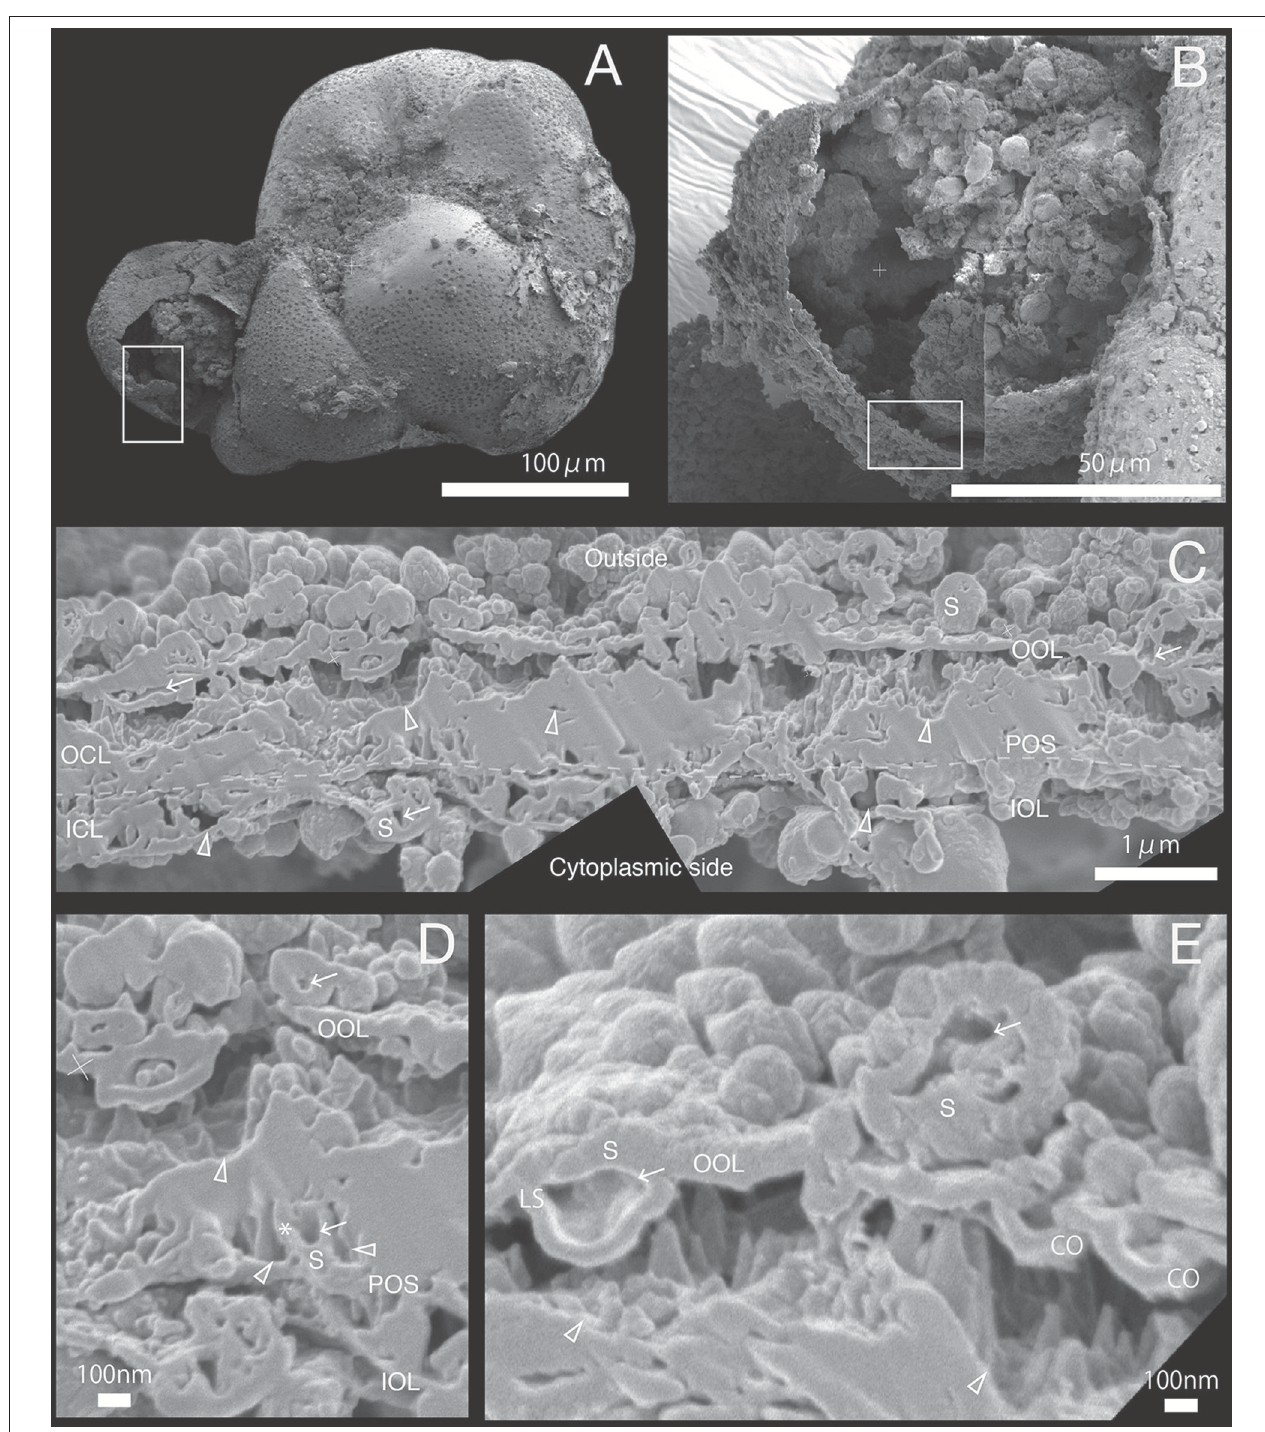
FIGURE 5 | SEM images of specimen #4. (A) Overview. (B) The newly calcified chamber (white rectangle in (A) . The field of FIB processing is indicated by the white rectangle. (C) Composite SEM image of the FIB processed SOC. The upper side is the outer side and whereas the lower side is the cytoplasmic side. White dotted line in the calcareous layer indicates the boundary between outer side and cytoplasmic side of calcareous layer. (D) Magnified image of spherical structure on primary organic sheet. (E) Higher magnification showing the outer organic layer is cave into void of outer calcareous layer (CO). A cavity (white arrow) can be identified on spherical structure of outer organic layer (LS). OOL, outer organic layer; OCL, outer calcareous layer; POS, primary organic sheet; ICL, inner calcareous layer; IOL, inner organic layer; S, spherical structures; CM, calcareous materials; PP, pore plate; gray triangles, void; white arrows, cavities in the organic structure; CO, concavity; asterisk, opening spherical structure from cavity into void; LS, spherical structure with larger cavity.